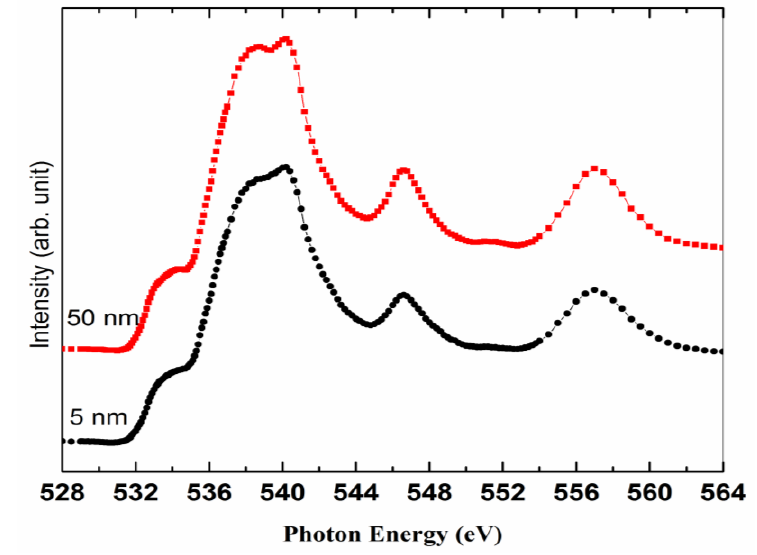
Figure 1. O K -edge NEXAFS spectra of MgO thin films of thicknesses 5 and 50 nm.